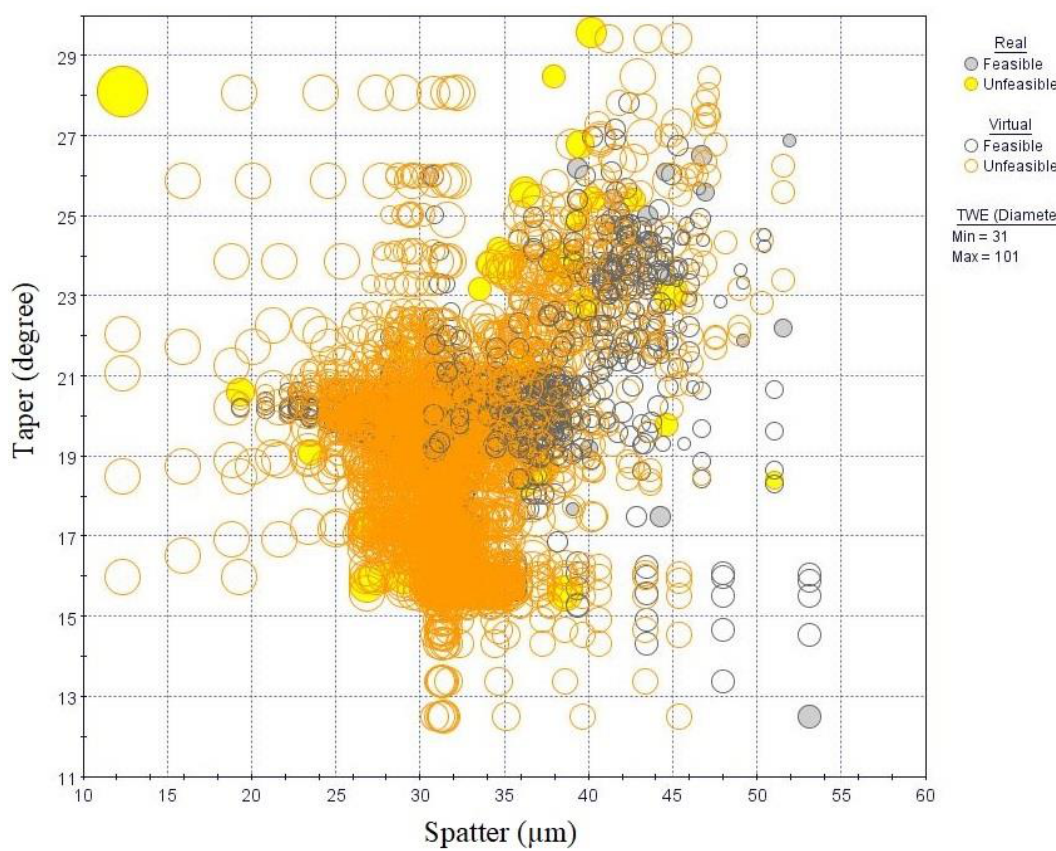
Figure 14. Three dimensional bubble chart with complete solution space.